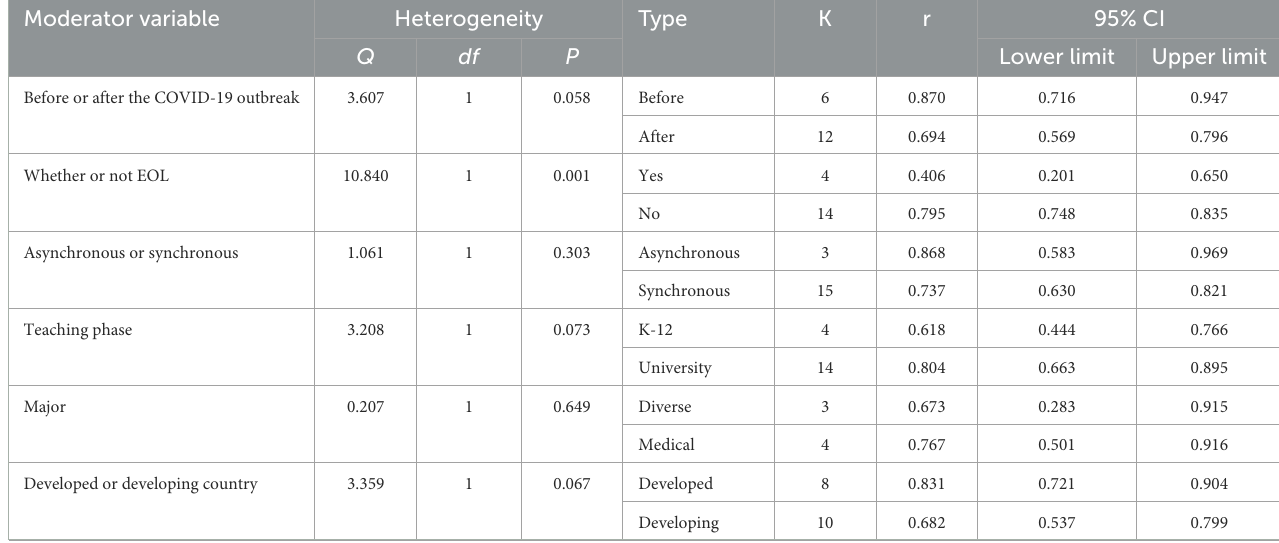
TABLE 7 Moderator analysis for faculty